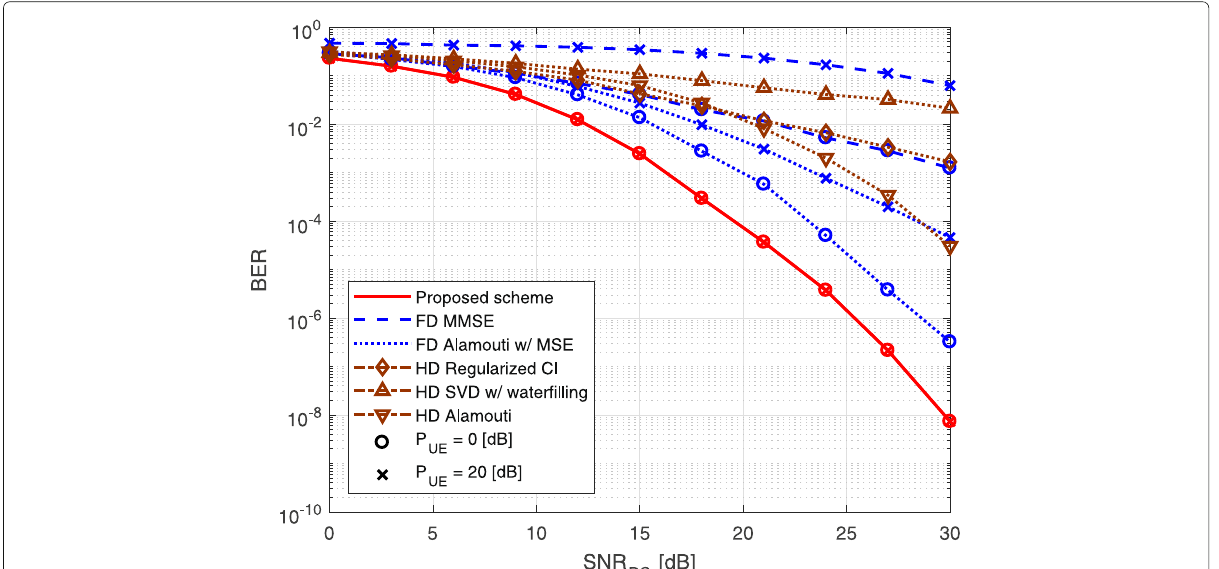
Fig. 2 The BER of the proposed scheme and the existing schemes according to BS transmission